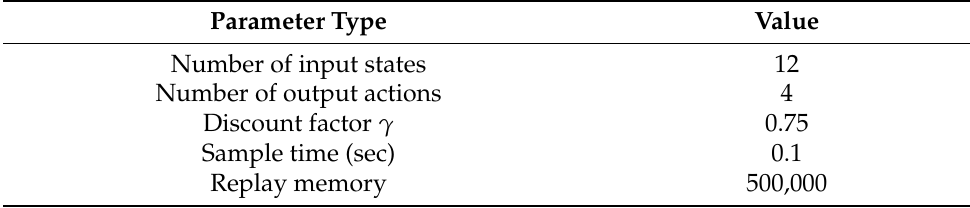
Figure 8. Result comparison between the proposed and DDPG agents. The parameters of both agents are presented in Table 2. Table 2. Parameters of twin-delayed deep deterministic policy gradient and DDPG